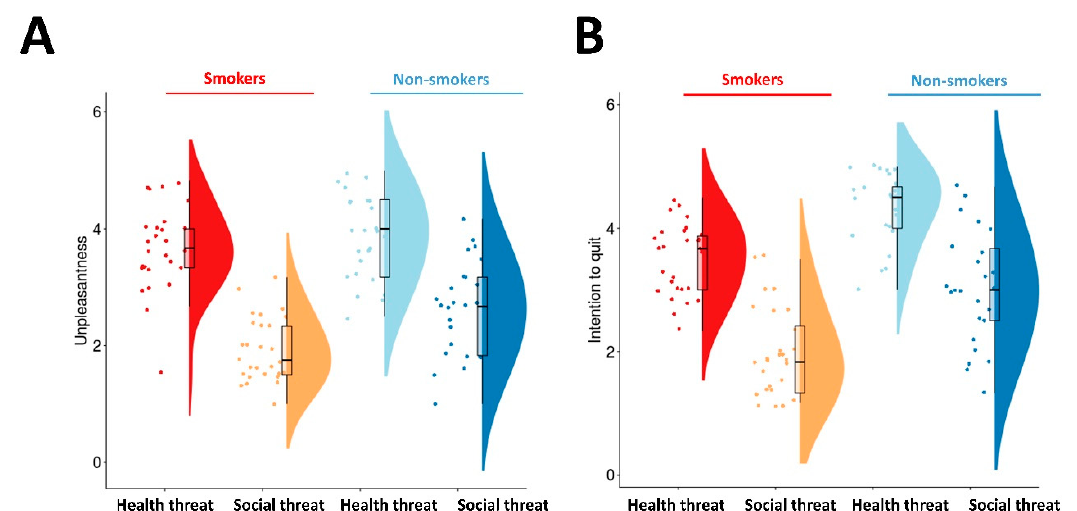
Figure 2. Psychophysical rating of the graphic health warnings on cigarette packs. ( A ): The unpleasantness of the two di ff erent types of graphic health warnings (GHWs) was compared between smokers and non-smokers. ( B ): The intention to quit (not start) smoking in response to the two di ff erent types of GHWs was compared in smokers (non-smokers). Both groups showed a greater intention to quit smoking or remain a non-smoker in response to H-GHWs than to S-GHWs.